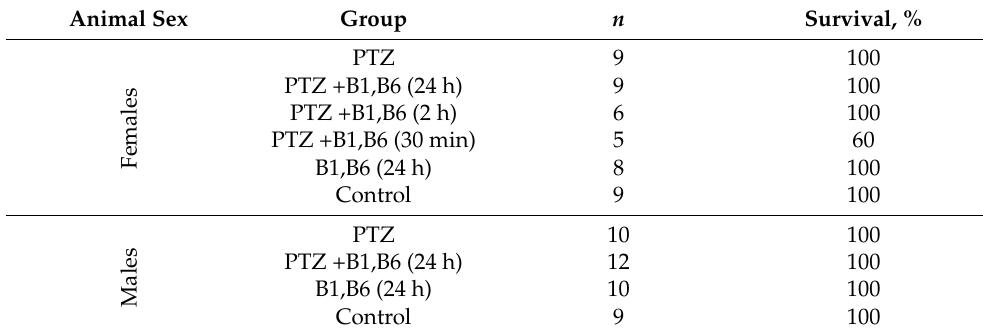
Table 2. Initial number of animals and their survival in each group. Animal